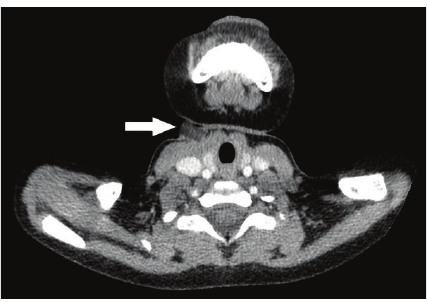
Figure 3: The foreign body after